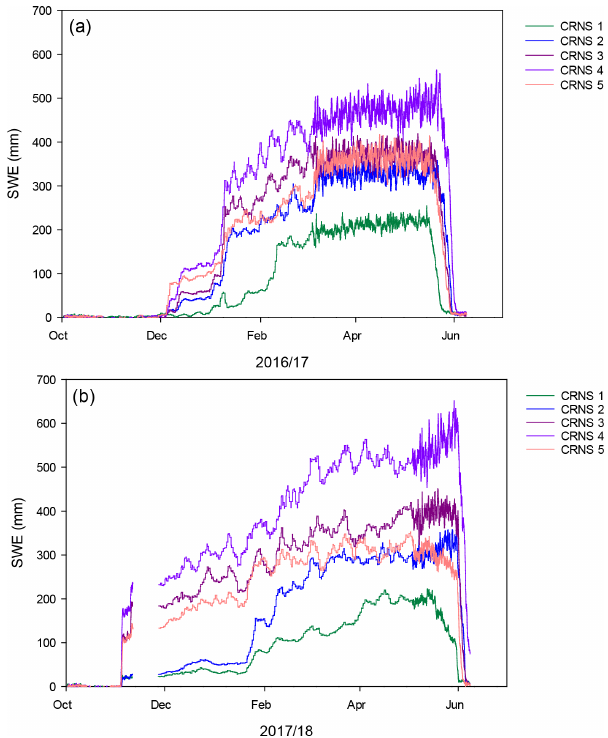
Figure 8. Change in SWE at TVC from each CRNS throughout the (a) 2016/2017 and (b) 2017/2018 winter seasons. CRNS 1 and 5 are located at the edges of the shrub patch, and CRNS 2 to 4 are located in the center of the